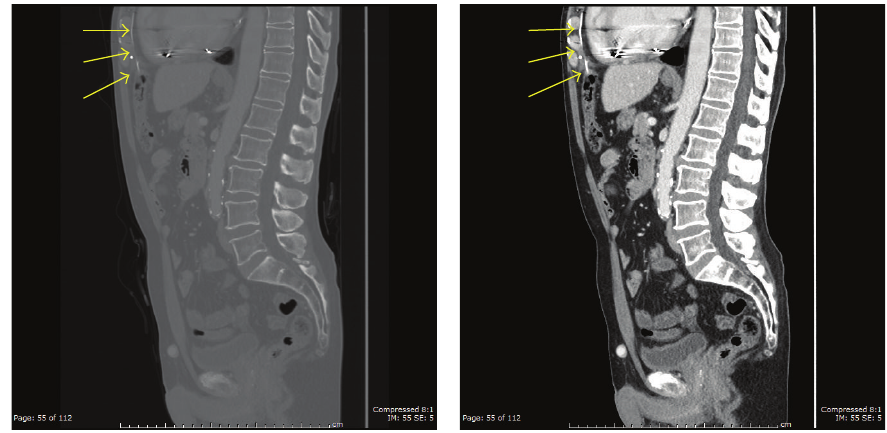
Figure 6: Sagittal images in bone and soft tissue windows revealing hyperdense wire (yellow arrows) vertically oriented in the substernal space traversing the sternocostal triangle (foramen of Morgagni) and piercing the transverse colon